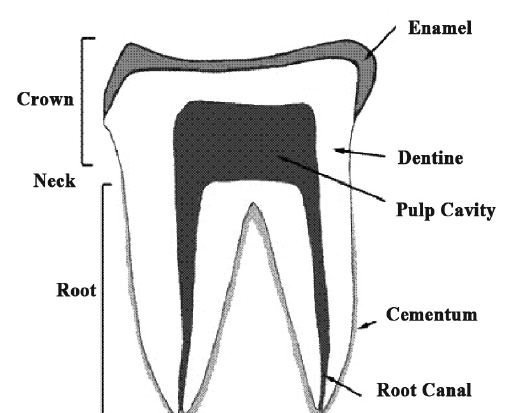
Fig. 1. Diagrammatic representation of a mammalian tooth in buccal-lingual section.